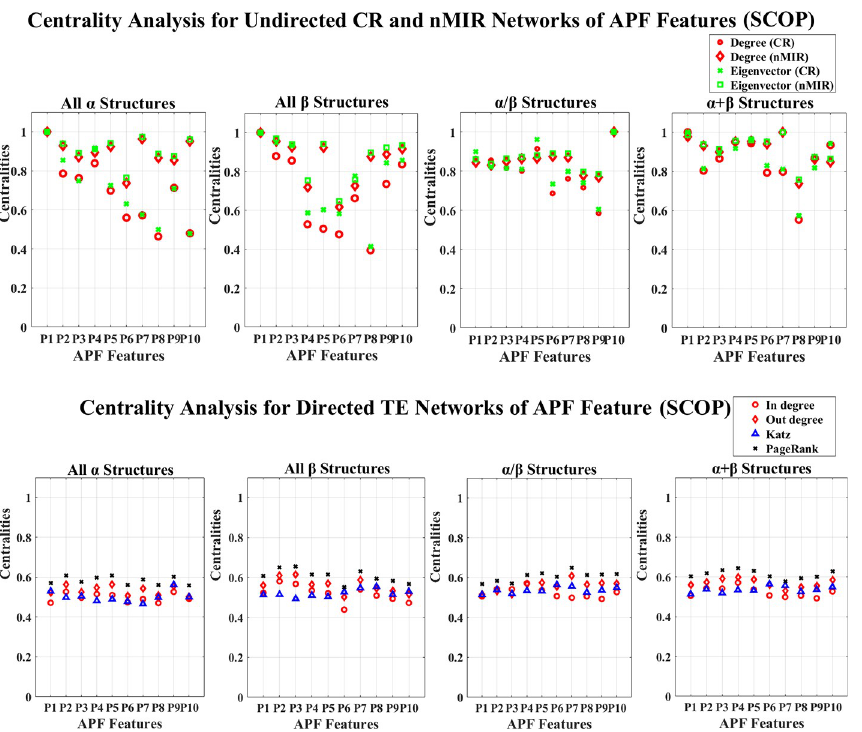
Fig 10. Centrality analysis for the networks of PseAAC features with λ = 0 (SCOP). This figure shows the centrality results for the undirected CR and nMIR networks (upper plots) and the directed TE networks (bottom plots) for the PseAAC features with λ = 0 (SCOP